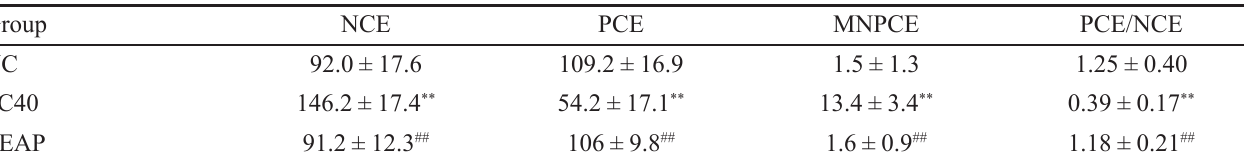
NC: negative control; PC40: positive control (cyclophosphamide 40 mg kg -1 ); EEAP (100 mg kg -1 ): group treated with the